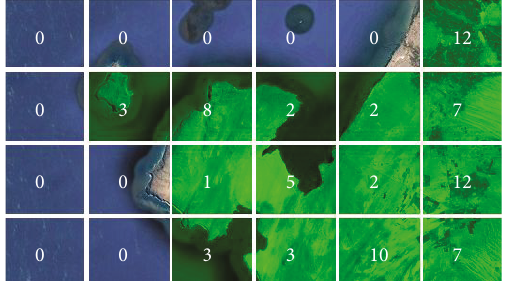
Figure 7: CSA result with threshold T = 0 .